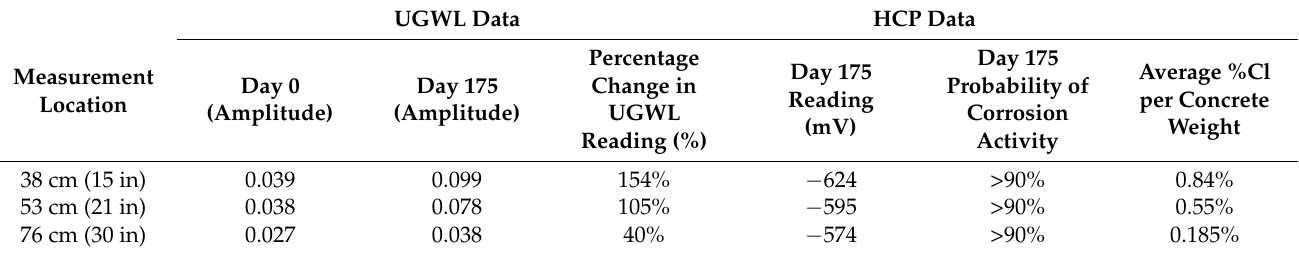
Table 8. Correlation between CTL and UGWL data.